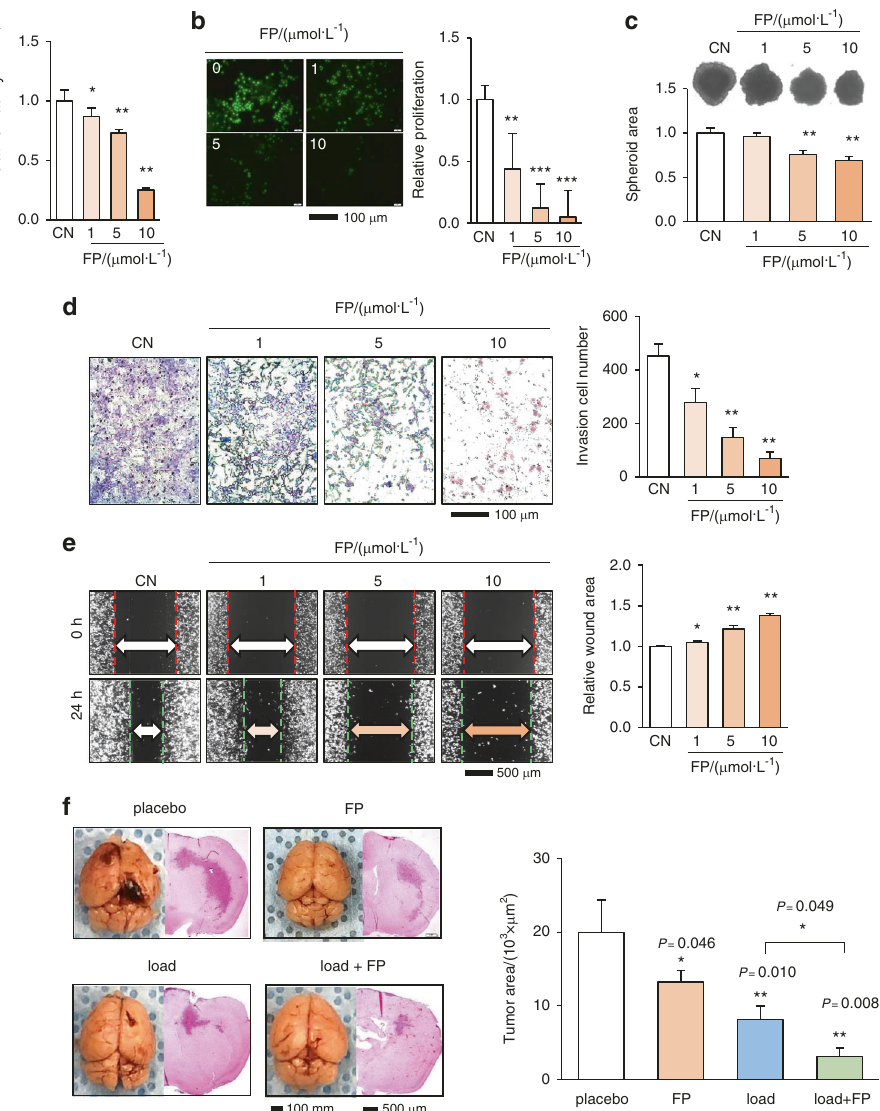
Fig. 3 Inhibitory effects of fl uphenazine (FP) on tumorigenic behaviors of 4T1Br cells. CN control, FP fl uphenazine, pl placebo, load tibial loading. The single and double asterisks indicate P < 0.05 and 0.01, respectively. a – c Reduction in MTT-assessed viability, EdU-measured proliferation, and the size of tumor spheroids induced by FP. d , e Decrease in the Transwell invasion and scratch assay migration after exposure to FP. f Reduction in the tumor area in the brain of BALB/c mice by daily tibial loading with and without FP administration. The whole-brain image and the H&E-stained coronal sections, including the maximum tumor area. The maximum tumor area in the coronal section was quanti fi ed, including the placebo and the tibia-loaded groups with and without FP administration ( N = 6 per